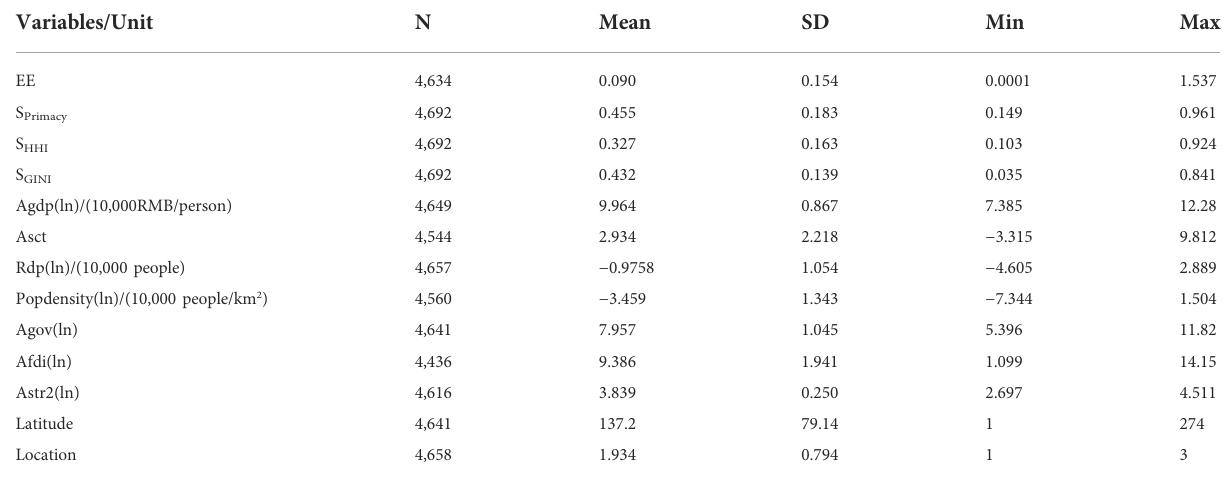
TABLE 5 Summary statistics.